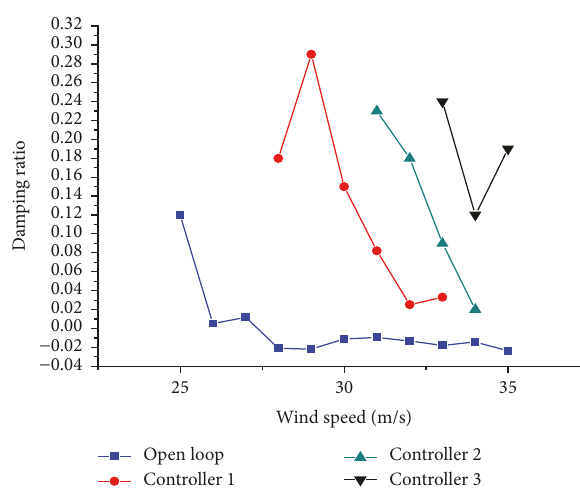
Figure 14: Damping ratio of open and closed-loop systems.